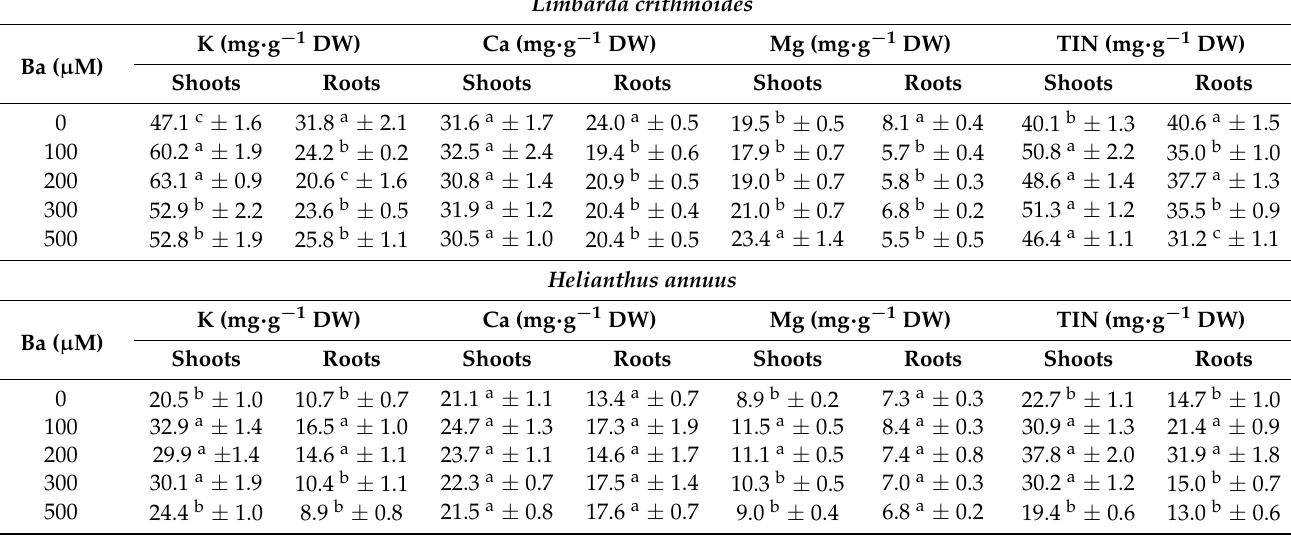
Table 3. Nutrient elements uptake in the shoots and roots of Limbarda crithmoides and Helianthus annuus over 45 days of Ba exposure (K: potassium, Ca: calcium; Mg: magnesium, TIN: total inorganic nitrogen). Data are shown as means ± SD; values with lowercase denote significant differences at p <